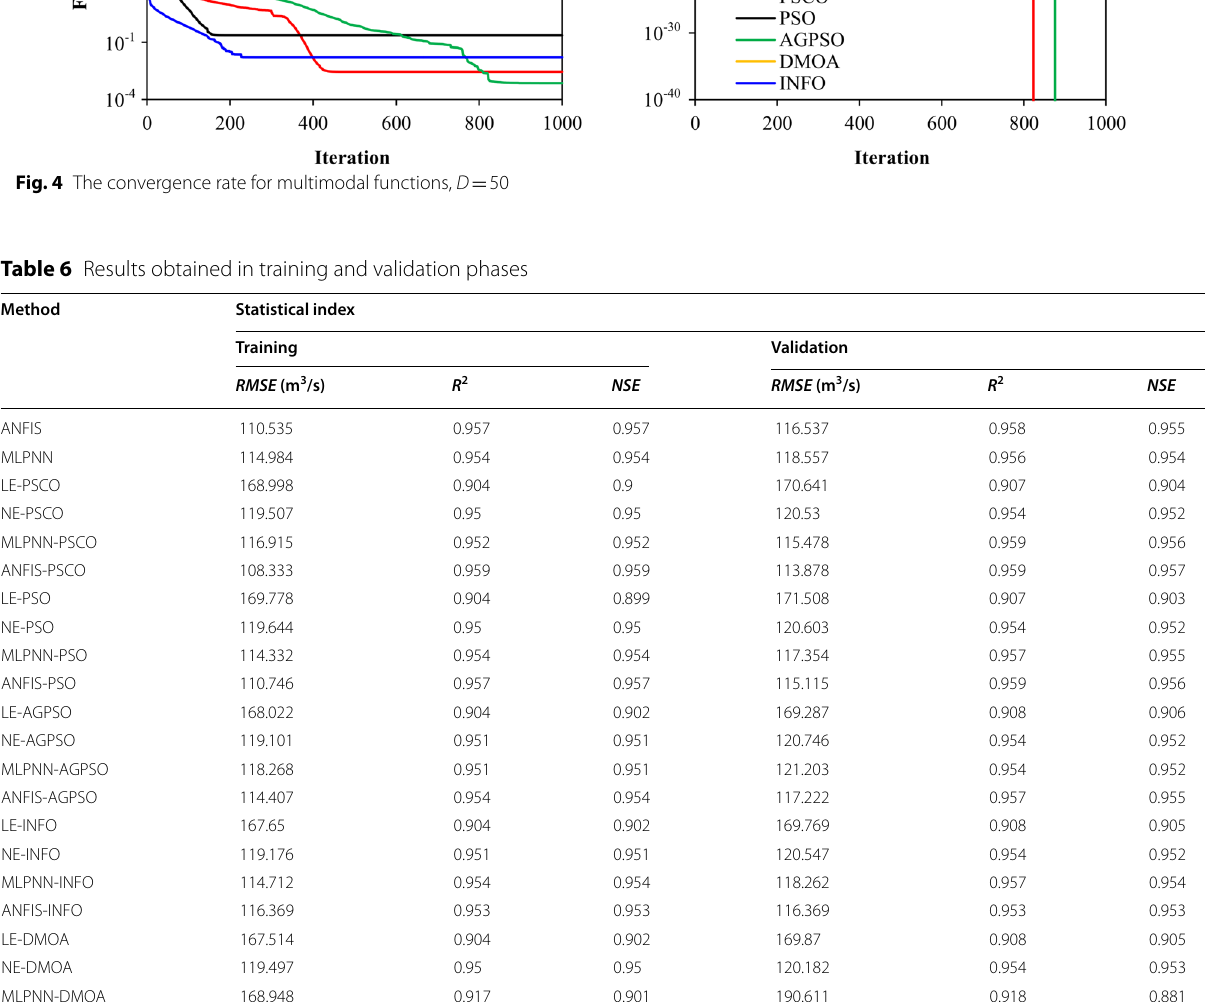
Fig. 4 The convergence rate for multimodal functions, D